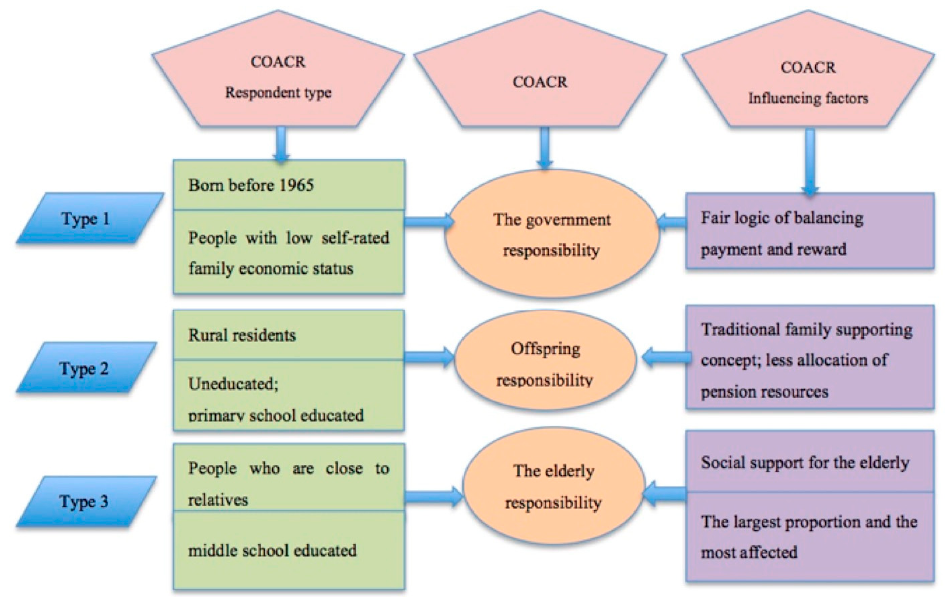
Figure 3. Differences of COACR and Influencing Factors. Source: designed by the authors. Note: COACR is an abbreviation of cognition of old-age care